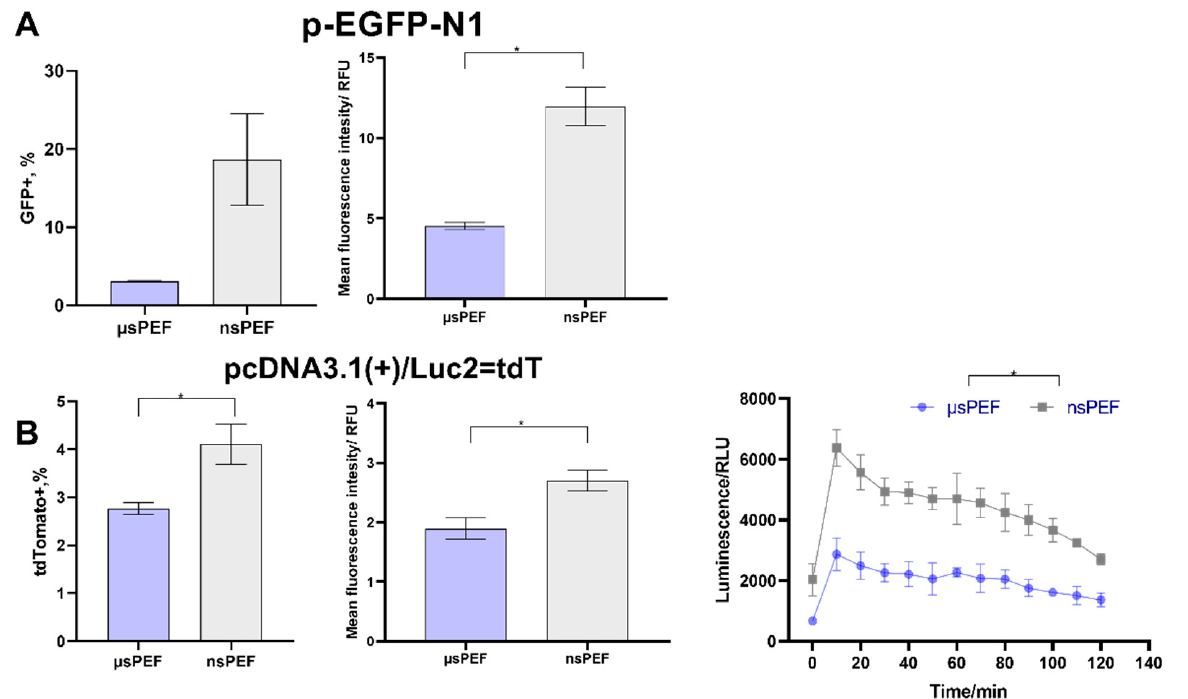
Figure 5. Transfection efficiency of primary murine DCs during microsecond and nanosecond electroporation, using ( A ) pEGFP-N1 plasmid and ( B ) pcDNA3.1(+)/Luc2 = tdT plasmid. The MFI was normalized to negative control. Asterisk (*) corresponds to statistically significant ( p < 0.05) difference.